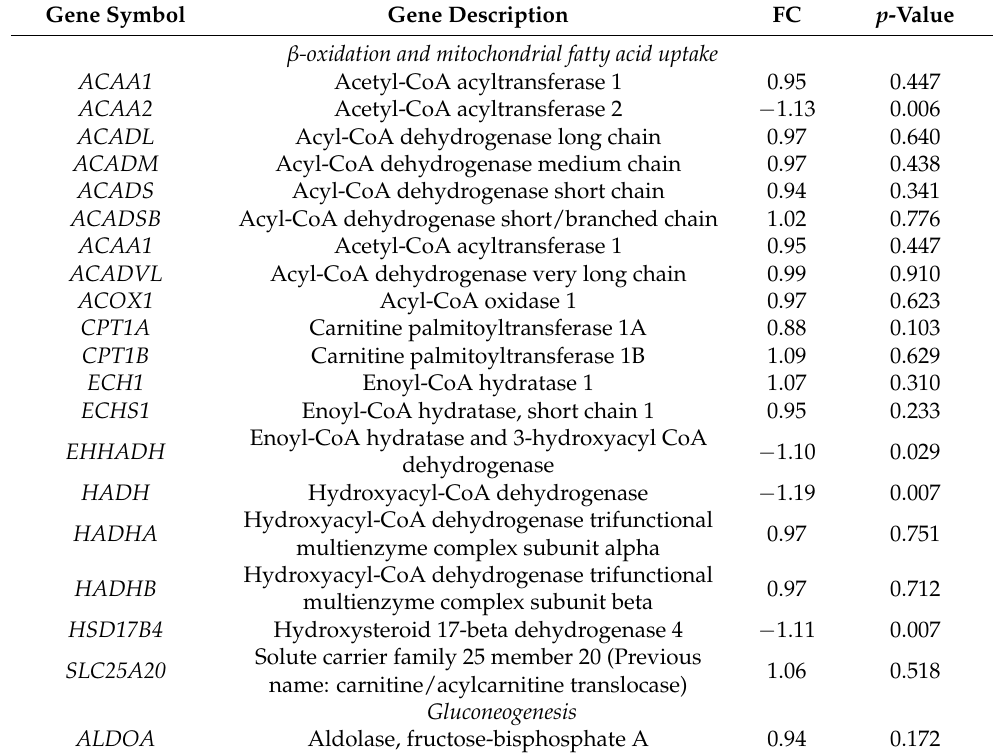
Table 3. Expression [fold change (FC)] of hepatic genes involved in β -oxidation and mitochondrial fatty acid uptake, gluconeogenesis, ketogenesis, and the tricarboxylic acid cycle in cows with high vs. low hepatic FGF21 expression at week 1